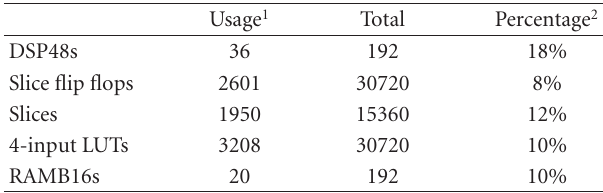
Table 2: FPGA resource